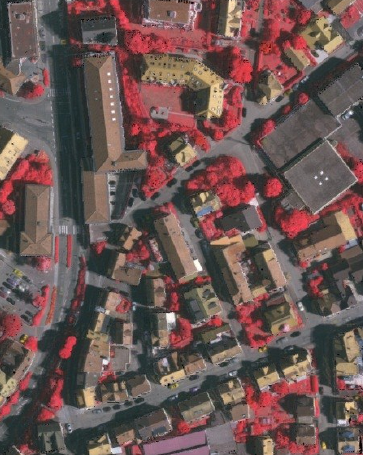
Figure 3. Generated true ortho photo for the first area